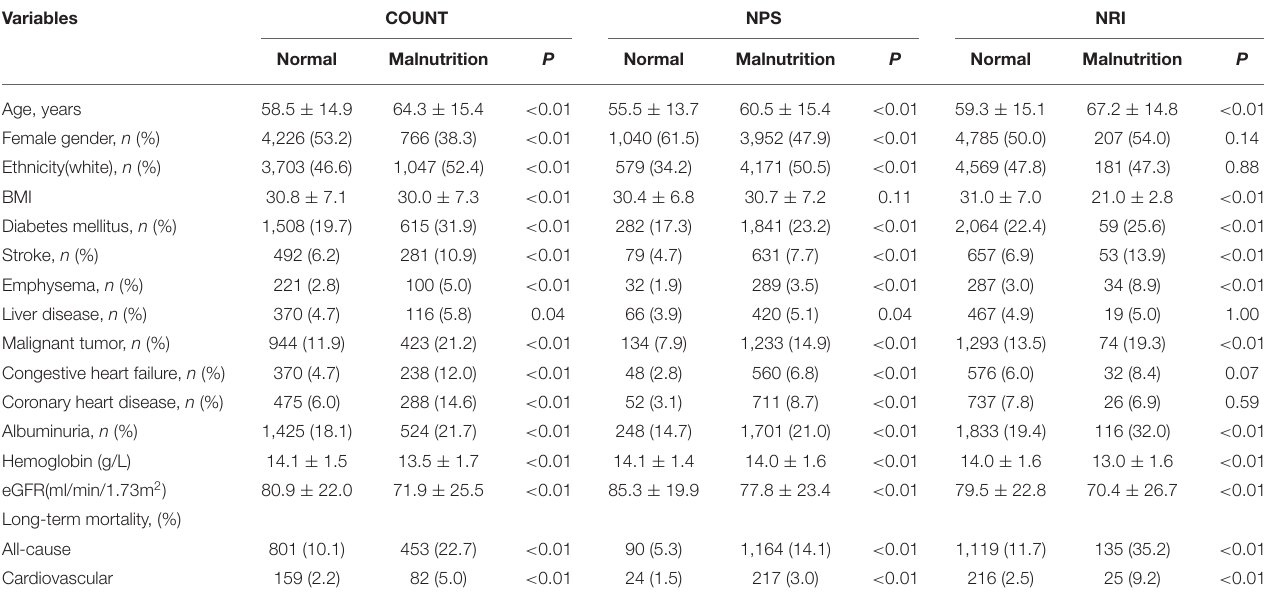
TABLE 3 | Comparison of characteristics of study population by different nutritional